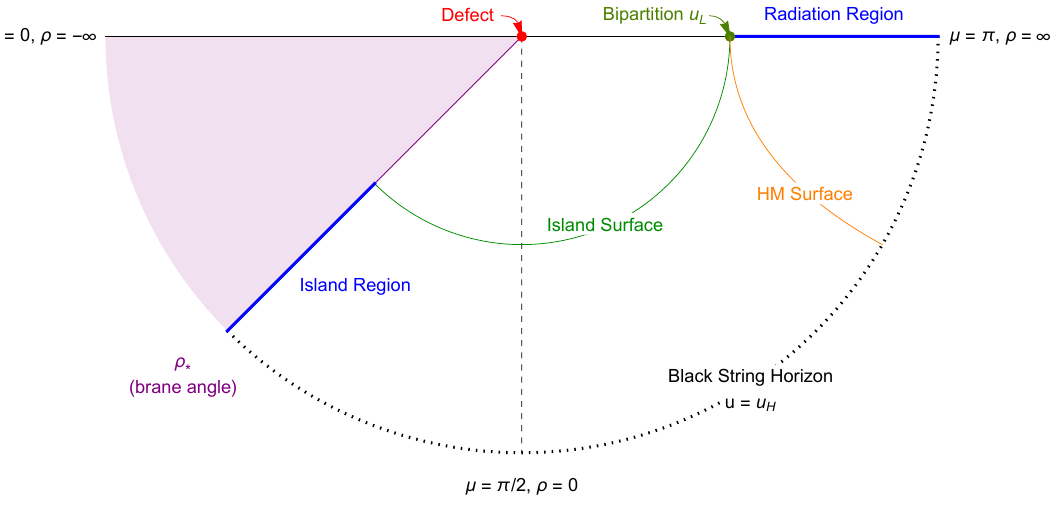
Figure 4 . A cartoon representation of the “left-side” thermofield double is shown here in the Poincaré half-plane. The light purple shaded region is excised from the AdS bulk by the KR brane at constant angular coordinate ρ ∗ . The convenience of the ρ coordinate over the µ coordinate is clear here — we have conformally compactified the braneworld’s infinite extra dimension into this finite diagram, so it now runs along the angular coordinate in the Poincaré half-plane and we identify µ = 0 , π , π with ρ = −∞ , 0 , ∞ , respectively. Also shown are the island and radiation regions, drawn 2 in blue, and the island surface and HM surface, drawn in green and orange, respectively. The black string horizon forms a dotted arc at the coordinate u = u H . For the eternal black string, we must also consider the “right-side” thermofield double, which looks identical to the diagram above, except that we allow a bipartition for the radiation region at a different coordinate u = u R , where we may have u L 6 = u R